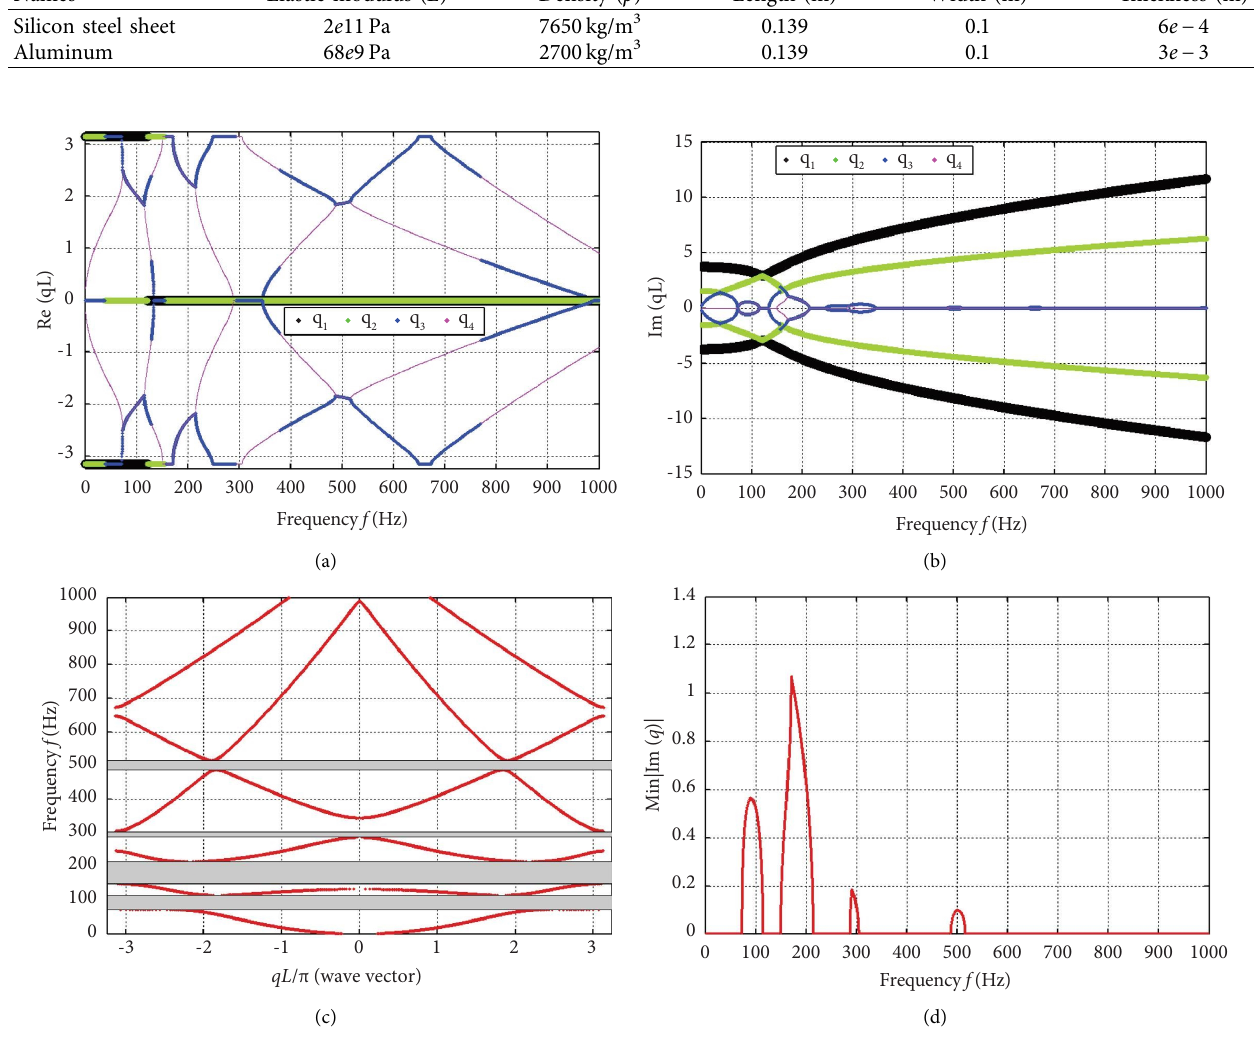
Figure 9: Bandgap structure of double-beam metamaterial: (a) real parts of wave number pairs, (b) imaginary parts of wave number pairs, (c) dispersion of double-beam metamaterial, and (d) minimum absolute value of attenuation